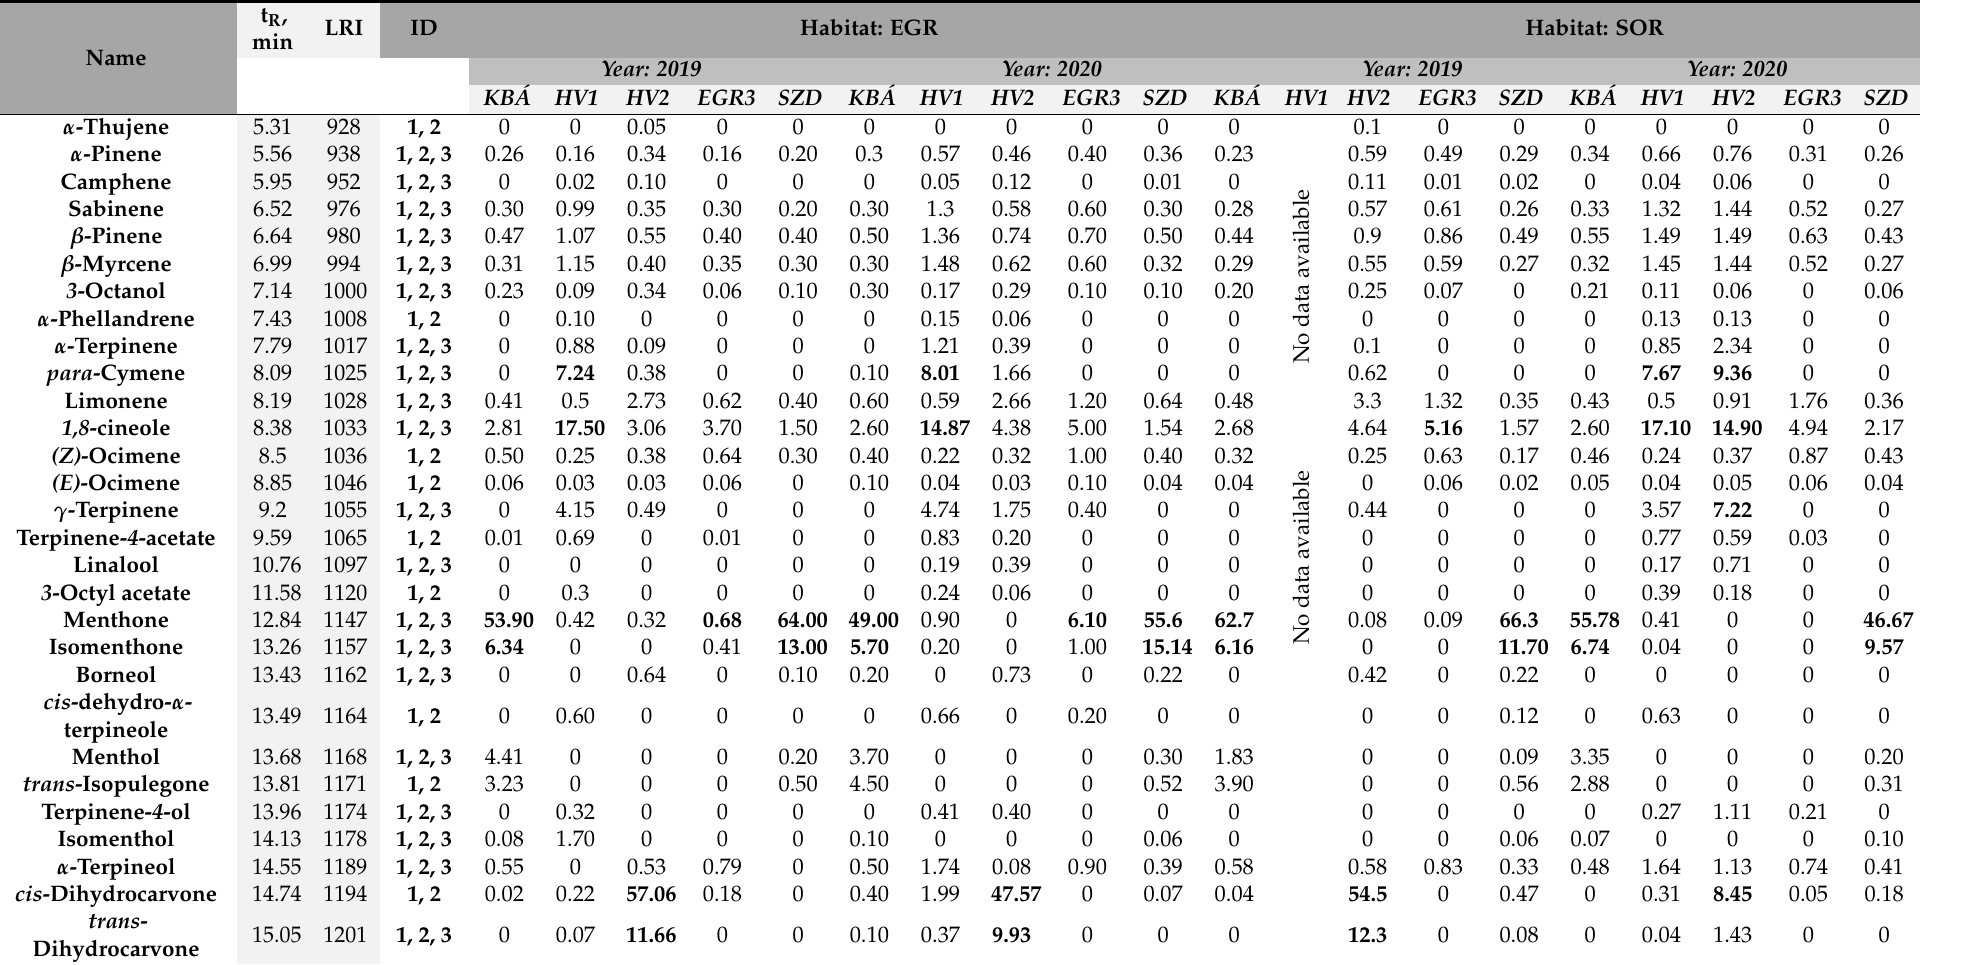
Table 2. Essential oil composition of the five accessions of horsemint in the cultivation experiment, given in area percentage. Abbreviations in this table are as follows: FA : fatty alcohol, LRI : linear retention indices, PMA : polymalonate, polyketide pathway product, pw : pathway, and t R : retention time (minute). Concentrations above 5% area are shown in bold. Numbers denoting ways of identification ( ID ): 1 public MS databases [39,40] 2 LRIs, and 3 MS library of standards made on the